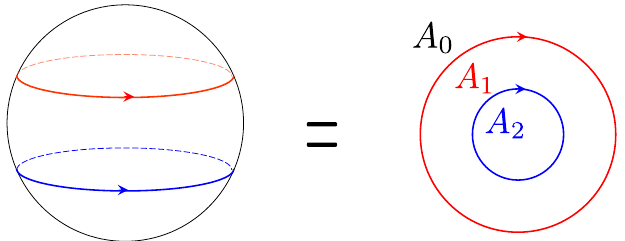
Figure 5. The correlation function of multiple fundamental Wilson loops. When viewed from the south pole, it can be represented as multiple concentric loops as shown on the right hand side of the figure. We count the loops from the north pole to the south pole and denote the area inside the j -th loop by A j